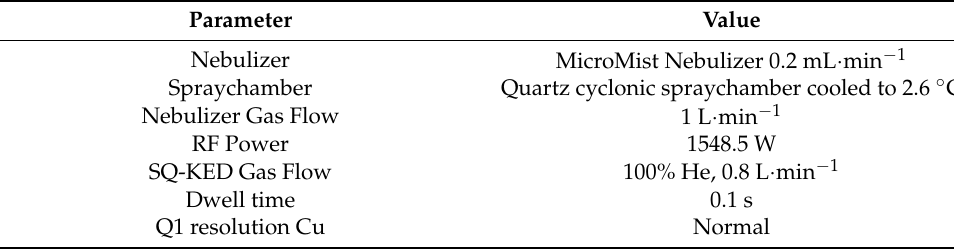
Table 2. Operating conditions of iCAP TQ